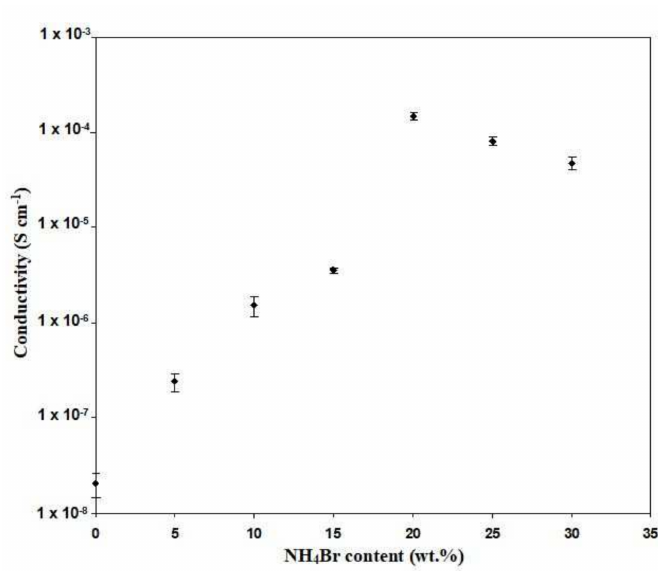
Figure 3. Conductivity versus NH 4 Br content at room temperature.